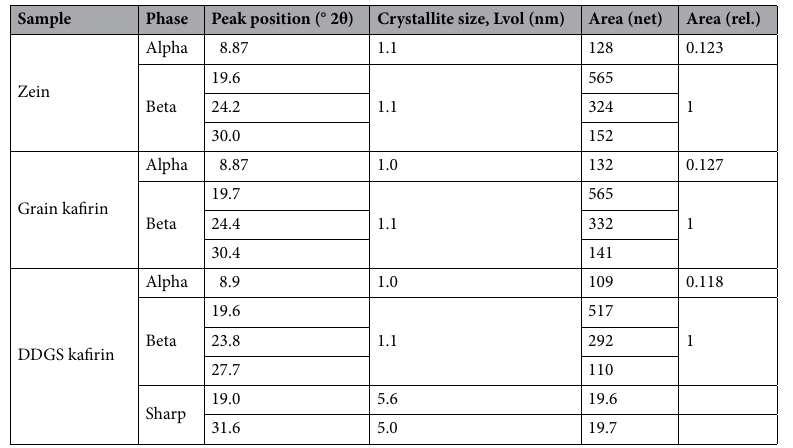
Table 1. Diffraction peak position, crystallite size and relative peak areas for zein, grain kafirin and dried distillers grain with solubles (DGGS) kafirin as measured by cx-ray diffraction (XRD).